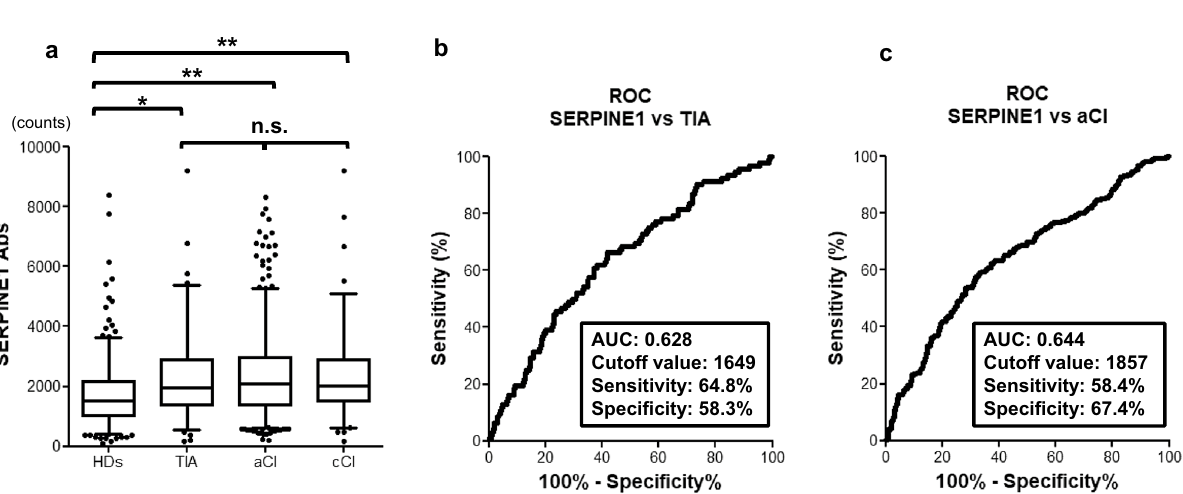
Figure 2. Comparison of serum SERPINE1 antibody levels between the HDs and the ischemic groups. ( a ) Serum antibody levels against SERPINE1 protein quantified using amplified luminescence proximity homogeneous assay-linked immunosorbent assay (AlphaLISA) and compared between the HDs and the patients in the TIA, aCI, and cCI groups. The Alpha photon counts represent the antibody levels and are shown using a box-whisker plot. Horizontal lines represent medians, and boxes represent the 25th and 75th percentiles. Whiskers represent the 10th and 90th percentiles, and dots represent outliers. Differences were examined using Dunn’s multiple comparison test with type I error adjustment using the Bonferroni procedure. HDs, healthy donors; TIA, transient ischemic attack; aCI, acute cerebral infarction; cCI, chronic cerebral infarction; * p < 0.05; ** p < 0.001; n.s., not significant. The antibody level of SERPINE1 was analyzed on the basis of the receiver- operating characteristic (ROC) curve for comparison between TIA ( b ) and aCI ( c ). The numbers in the figures indicate the area under the curve (AUC), cutoff values, sensitivity, and